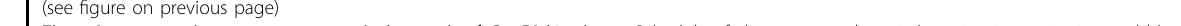
Fig. 1 Long-term immune responses in immunized C57BL/6 mice. a Schedule of chimpanzee adenoviral vaccine immunization and bleeding strategies in female C57BL/6 mice (6 – 8-week-old). Eight groups ( n = 5) of C57BL/6 mice were i.m. injected with 2 × 10 10 vp viruses. Serum samples were then collected at different time points. b Kinetics of spike-speci fi c total IgG reciprocal endpoint titers (log10) were measured within 27 weeks of initial vaccination. Total IgG immune responses were measured using ELISA. c Kinetics of SARS-CoV-2 pseudovirus neutralizing antibody NT 50 titers (log10) were measured within 27 weeks after the fi rst vaccination. d Measurement of live SARS-CoV-2 virus neutralizing antibody NT 50 titers of sera collected at week 24. e Neutralization of variant B.1.1.7 SARS-CoV-2 pseudovirus in serum samples obtained at week 27 post initial immunization. Unpaired t -test was used for analysis. f Neutralization of variant B.1.351 SARS-CoV-2 pseudovirus in serum samples collected at week 27 after the fi rst vaccination (unpaired t -test, P = 0.041). g Endpoint titer ratios of IgG2a to IgG1 were calculated. Mouse sera were collected at week 8, and subtypes IgGs were assessed by ELISA. Sera of mice immunized with AdC6-empty and AdC68-empty were not calculated, as the endpoint titer did not reach the lower limit of detection (LLOD). h , i Intracellular cytokine staining was performed in mouse spleen to assess memory T cells at week 27, and cytokines IFN- γ and TNF- α were detected. All data were shown as means ± SEM. P -values were analyzed with one-way ANOVA ( ns P ≥ 0.05; * P < 0.05; ** P < 0.01; *** P < 0.001; **** P <